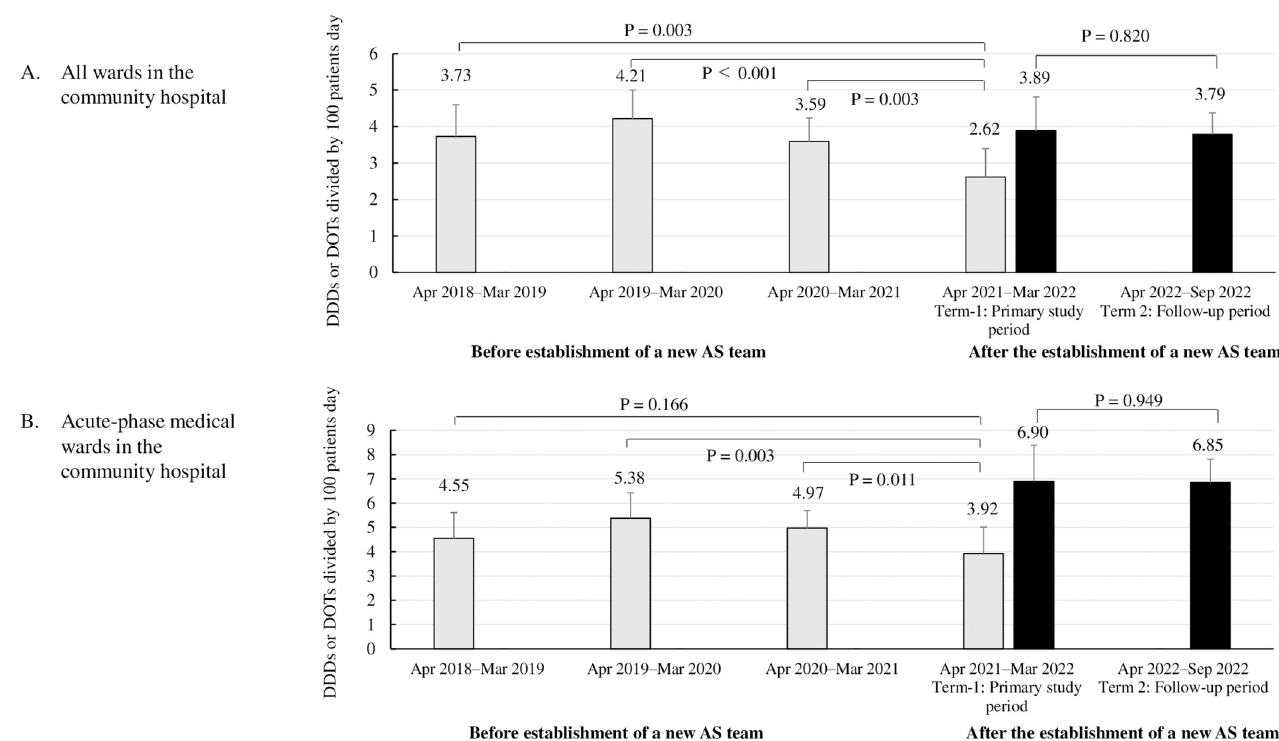
Fig 2. Change of antibiotic use of broad-spectrum antibiotics before and after a new antimicrobial stewardship (AS) team in the community hospital. DDD: defined daily dose; DOT: day of therapy. Grey bar showed mean monthly DDD and black bar showed mean monthly DOT during the corresponding period.